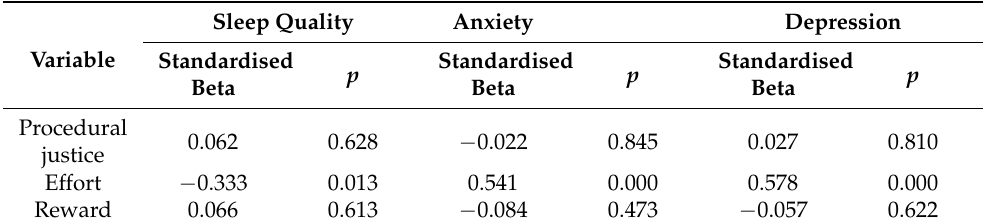
Table 5. Third wave health outcomes associated with procedural justice and occupational stress: a linear regression analysis adjusted for age and